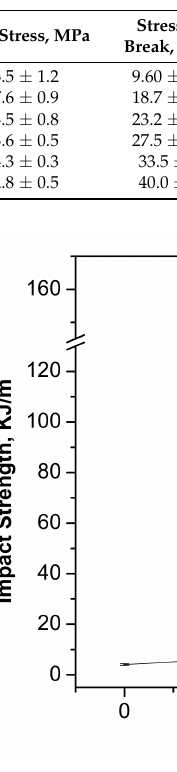
Figure 6. Impact strength of neat PPC and PPC/TPU blends as a function of TPU